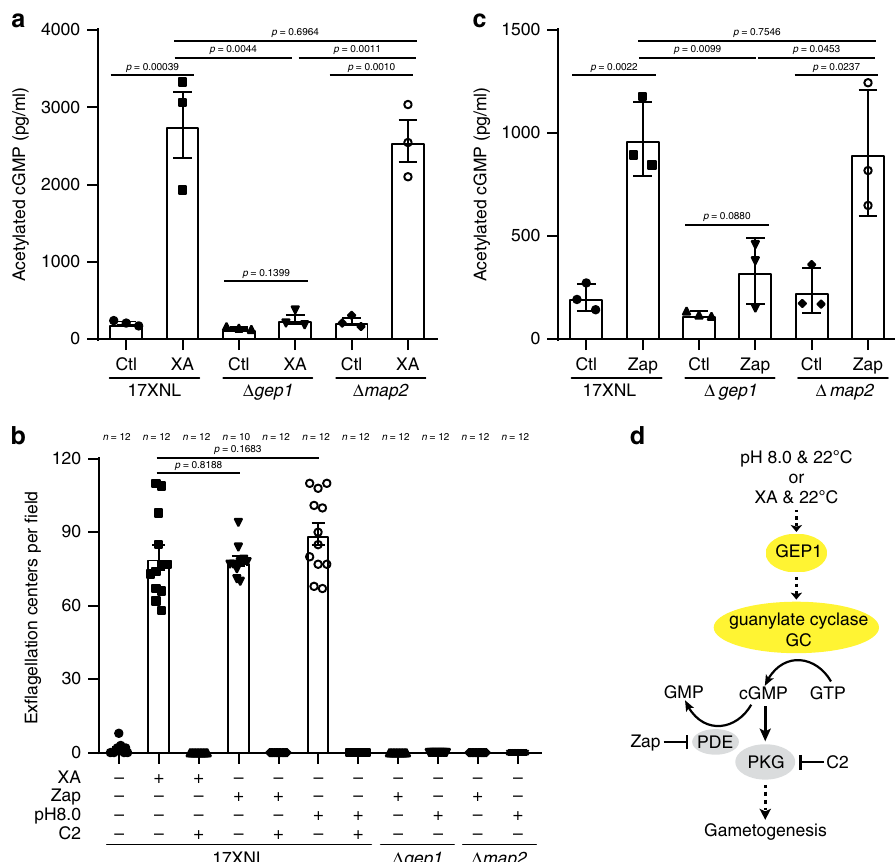
Fig. 4 Impaired activity of cGMP synthesis in GEP1 de fi cient gametocytes. a Enzyme immunoassay detecting intracellular cGMP level in XA-stimulated gametocytes of the 17XNL, Δ gep1 , and Δ map2 parasites. Cells were incubated with 100 μ M XA at 22 °C for 2 min before assay. Ctl are control groups without XA stimulation. b Ex fl agellation center counts of 17XNL, Δ gep1 , and Δ map2 parasites after treatment with XA (100 μ M), Zaprinast (Zap, 100 μ M), or pH 8.0 alone at 22 °C, or at the presence of compound 2 (C2, 5 μ M). n is the numbers of microscopic fi elds counted (40×). c Enzyme immunoassay detecting intracellular cGMP level in Zap-treated gametocytes of the 17XNL, Δ gep1 , and Δ map2 parasites. Cells were incubated with 100 μ M Zap at 22 °C for 2 min before assay. Ctl are control groups without Zap stimulation. d Proposed role of GEP1 in regulating cGMP synthesis activity of guanylyl cyclase in gametogenesis. All source data are provided as a Source Data fi le. Experiments in a , b , and c were repeated three times independently. Data are shown as mean ± SD; two-tailed unpaired Student ’ s t